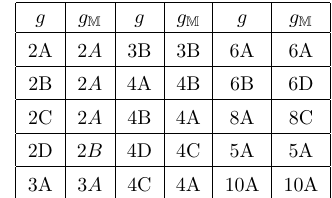
Table 4 . Generalized bilinear relation for 2 (cid:1) B .